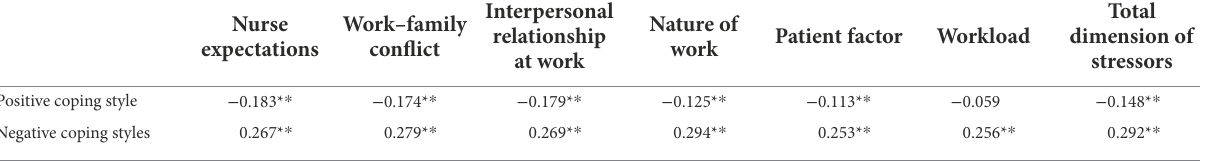
TABLE 4 Correlation between work stressors and coping styles of pediatric outpatient and emergency nurses ( n = 1,457).